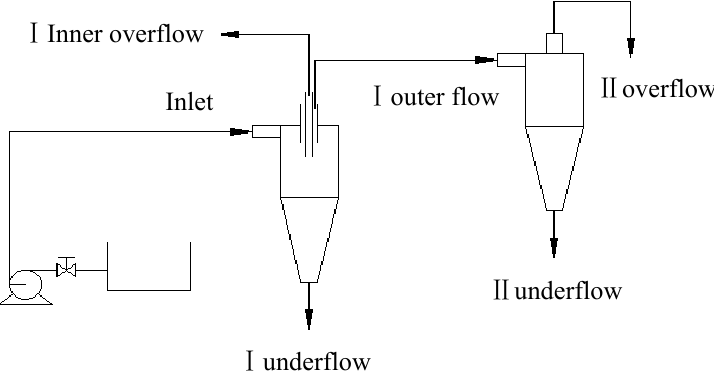
Figure 5. Four product cyclone with double vortex finders.